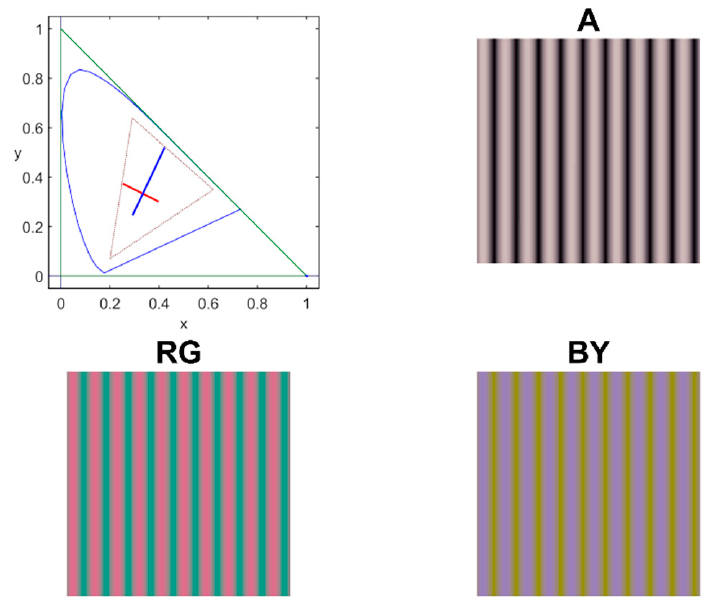
Figure 2. Example of the achromatic ( A ), red-green ( RG ), and blue-yellow ( BY ) sinusoidal patterns used in the CSF measurement. The chromaticity diagram shows the colour palette for the RG (red line) and BY (blue line) with maximum amplitude.